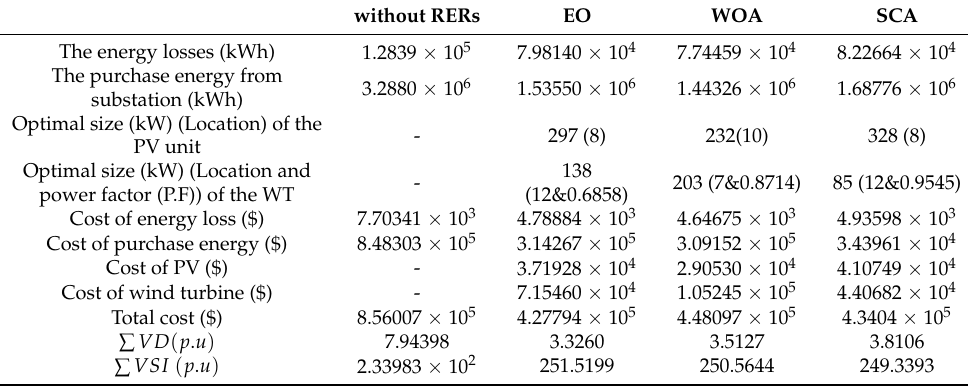
Figure 6. The hourly market price of the upstream grid. Table 4. The simulation results of energy management of the MG under deterministic conditions.